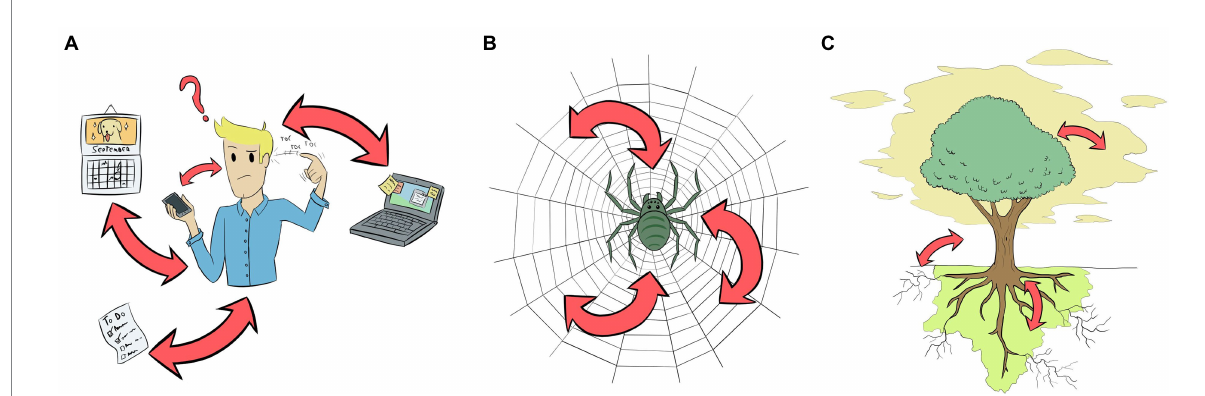
FIGURE 3 Representation of three different biological systems (two neural and one aneural) that may extend their cognitive process to the environment. Arrows represent the relationships between the organism and the objects that sustain the extended cognition (ExC). By experimentally manipulating these relations, ExC could be tested empirically. (A) Humans, the best-studied example, have a plethora of mechanisms for extending their cognitive process by modifying their environment, from ‘to-do lists’ to computers and cell phones. Gut microbiota could also be involved in human ExC (Boem et al., 2021), but is not represented here. (B) Spiders could extend their cognition to their webs; manipulations in the web lead to changes in spider cognitive states, and vice versa. (C) Plants are an example of aneural organism that could use ExC to support its cognitive process. In this case, through the manipulation of VOCs, root exudates and soil microbiota, and mycorrhizal symbionts. Similar processes may occur in other organisms without neurons or central nervous system like fungi, slime moulds and sea